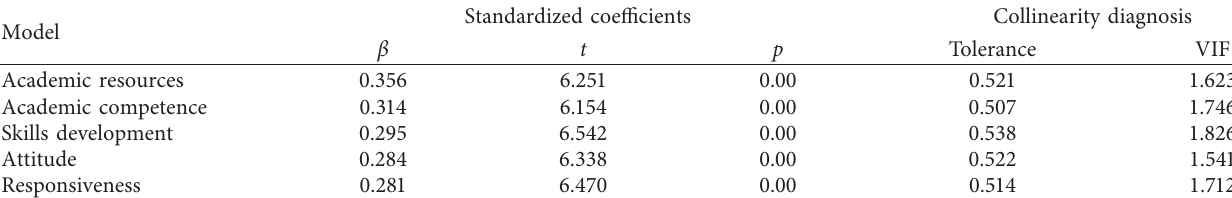
Table 5: Regression analysis for effects of service quality on organizational